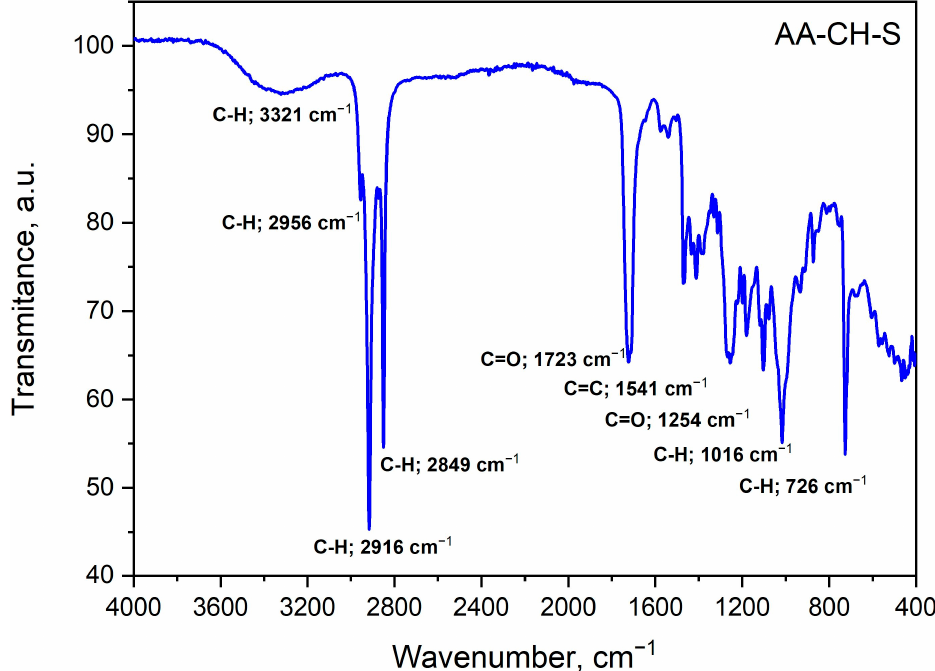
Figure 4. ATR FT-IR spectra of the AA-CH-S film.